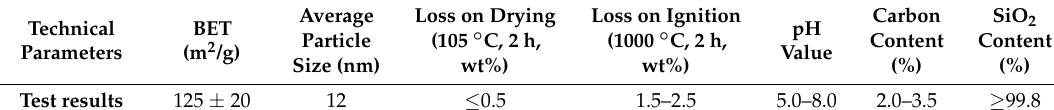
6 Table 2. Technical parameters of asphalt. Technical Parameters